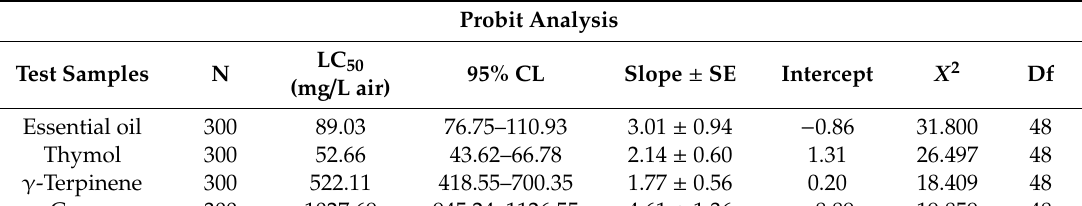
Table 3. Lethal concentration (LC 50 ) and 95% confidence limits (CL) estimated for the small hive beetles, 24h after fumigation exposure to T. ammi essential oil and its three main constituents.